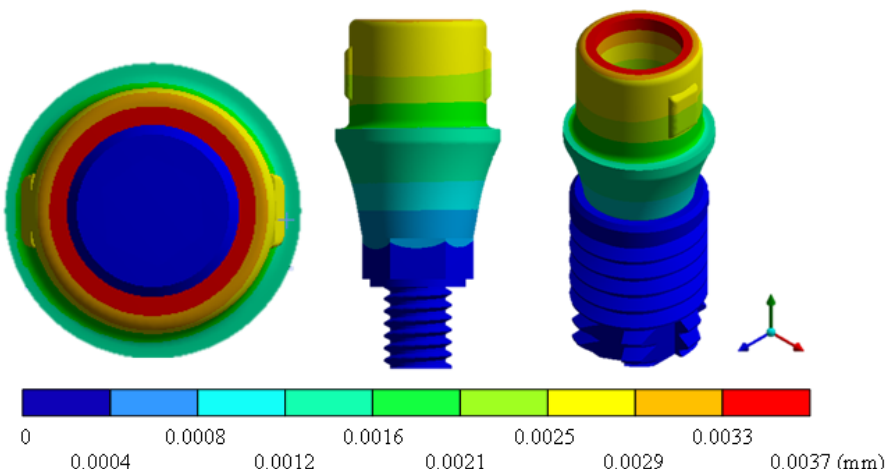
Figure 19. Total general displacement for Universal-type implant (ZrO 2